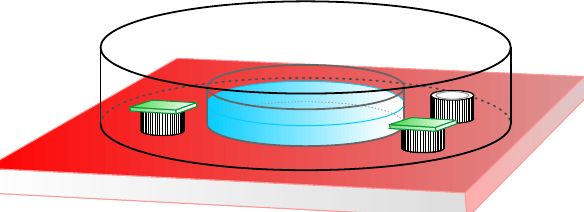
FIG. 14. False-color sketch of the solvent vapor exposure apparatus. The red stage represents the hot-plate surface kept at 50 °C during the process to promote evaporation of toluene (light blue) from a small petri dish placed atop. The lime-green pieces represent the substrates with glassy PFO layers cast uppermost. These samples are lifted above the hot-plate surface by about 1 cm using thermal-insulating plastic vial lids as stands. This way, we prevent direct thermal contact and thus any potential film crystallization into the α 0 -phase [113]. An enclosed chamber is achieved by placing a larger, upturned petri dish onto the hot-plate surface. The continuous vapor exposure period is set to one hour; the process is hence abbreviated as